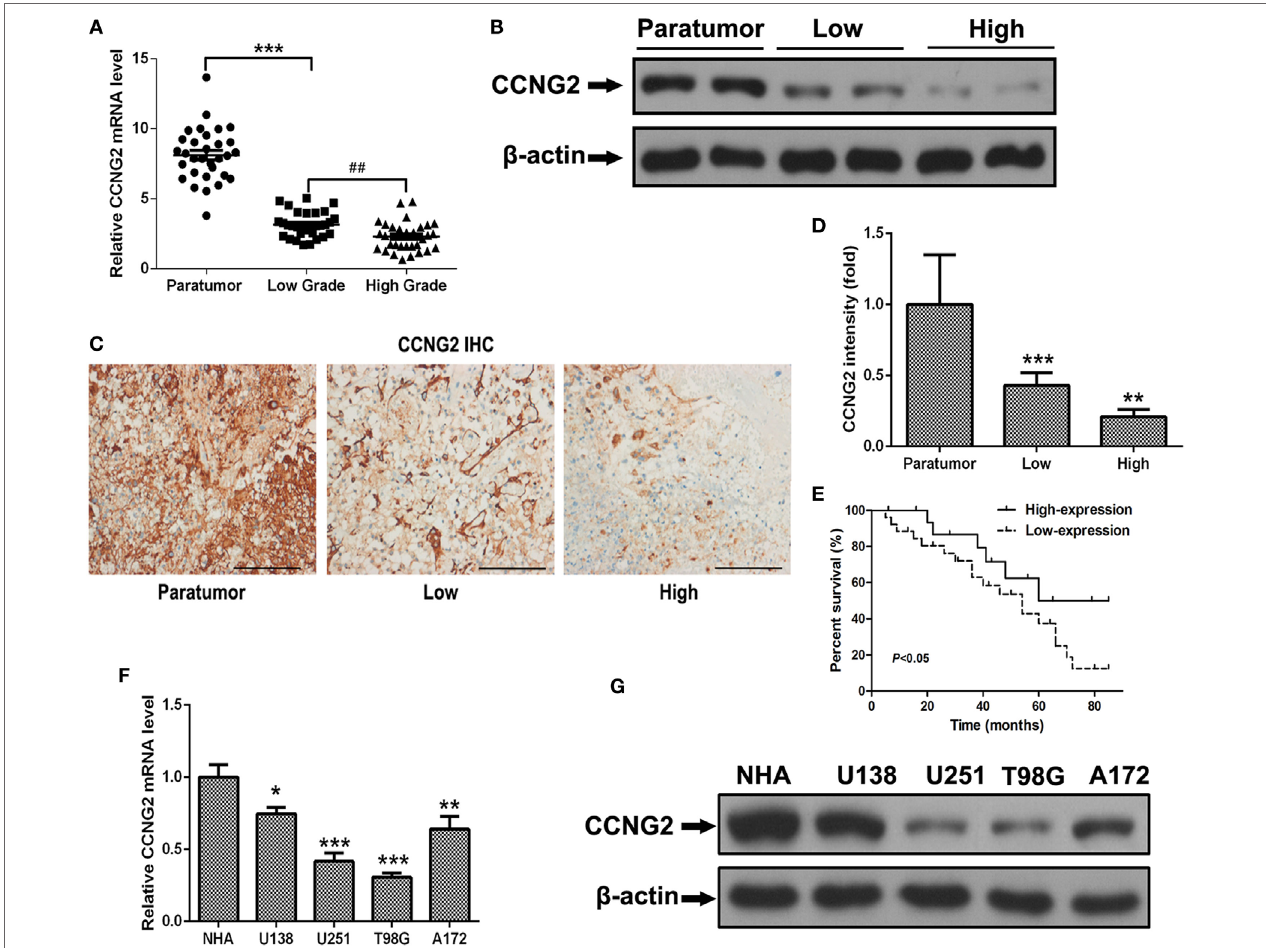
FigUre 1 | CCNG2 expression of patients with astrocytoma and glioma cell lines. (a,b) CCNG2 mRNA and protein levels were detected by RT-PCR and western blotting in low- and high-grade astrocytoma surgical samples ( n = 31) compared with paratumor samples ( n = 31). (c,D) Expression of CCNG2 was determined by immunohistochemistry staining in all tissues and quantified. Scale bars: 100 µm. (D) Kaplan–Meier survival curve of patients with low- and high expression of CCNG2. (e) CCNG2 expression levels in four glioblastoma cell lines and normal astrocyte cells ( n = 3) were analyzed by RT-PCR and western blotting. (F,g) CCNG2 mRNA and protein levels were detected by RT-PCR and western blotting in four cell lines (U138, U251, A172, and T98G).* P < 0.05, *** P < 0.001, ### P < 0.001 by unpaired two-tailed Student’s t